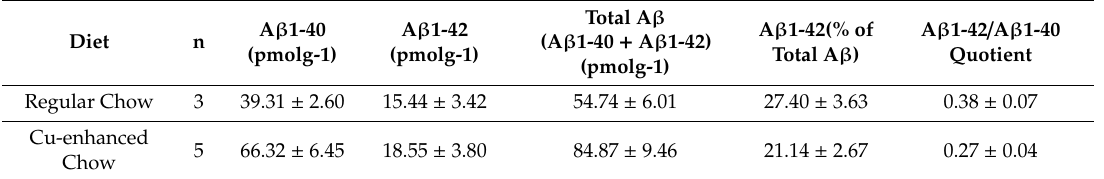
Table 4. Cu-enhanced diets exacerbated brain A β amyloidosis in APP / PS1 transgenic mice- ELISA